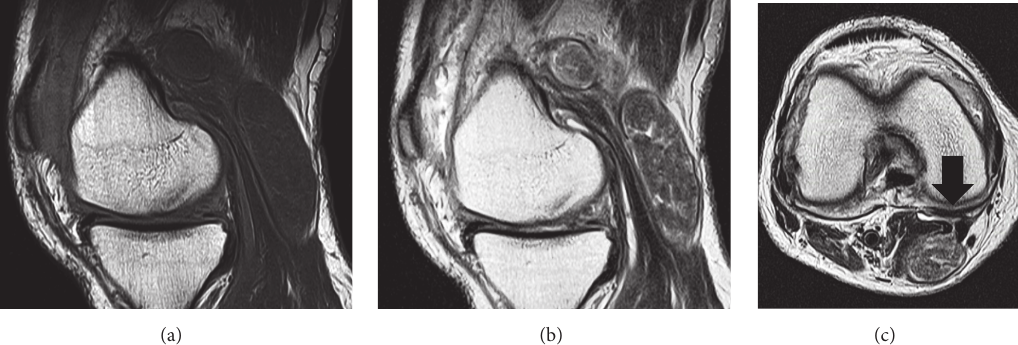
Figure1:PreoperativesagittalT1-weighted(a)andT2-weighted(b)andaxialT2-weighted(c)magneticresonanceimages.Acystwasdetected with low signal intensity on T1-weighted images and heterogeneous intermediate signal intensity on T2-weighted images. A connecting path was seen between the cyst and the subgastrocnemius bursa (arrow), compatible with the characteristics of popliteal